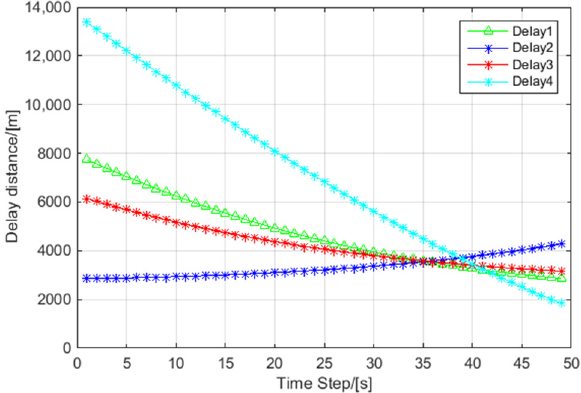
Figure 18. Time delay of four UAVs. Table 7. The pass ratio of same source testing under different radar resolution and different localization error (unit of pass ratio: %).